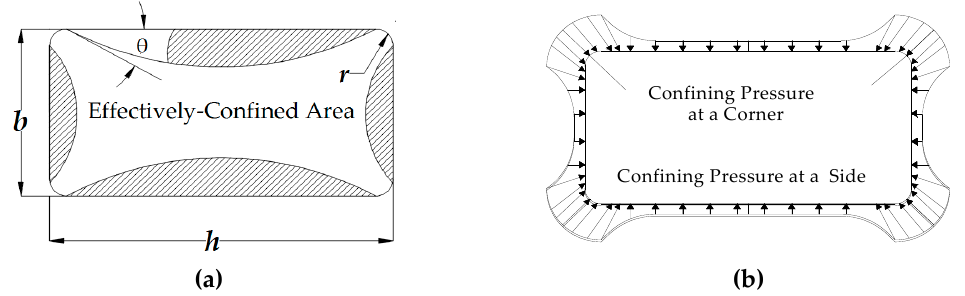
Figure 8. ( a ) Effectively-confined area; ( b ) Confining pressure at a corner and a side (modified from [51]).